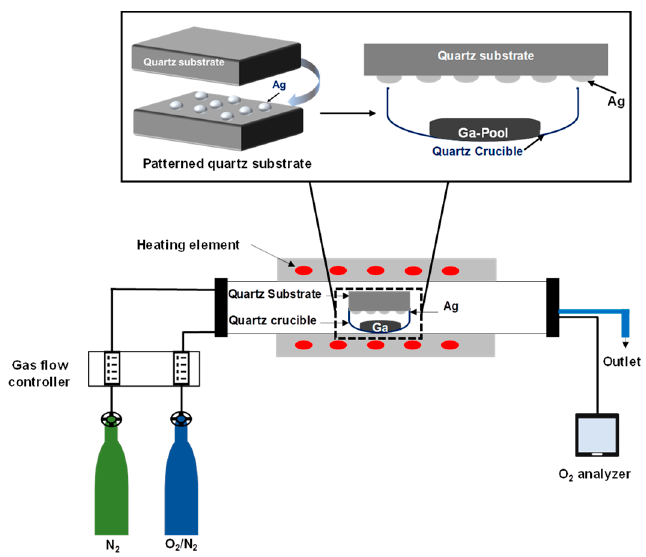
Figure 1. Schematic of the sample set-up inside the furnace, which was used to study the growth mechanism of gallium oxide on a quartz substrate coated with a 5 nm and 300 nm patterned Ag film sputtered by a shadow mask. The quartz substrate was placed over the Ga source, having the patterned surface facing downward over the Ga source. The Ga liquid pool is in a quartz crucible at a distance of ~10 mm from the sample.